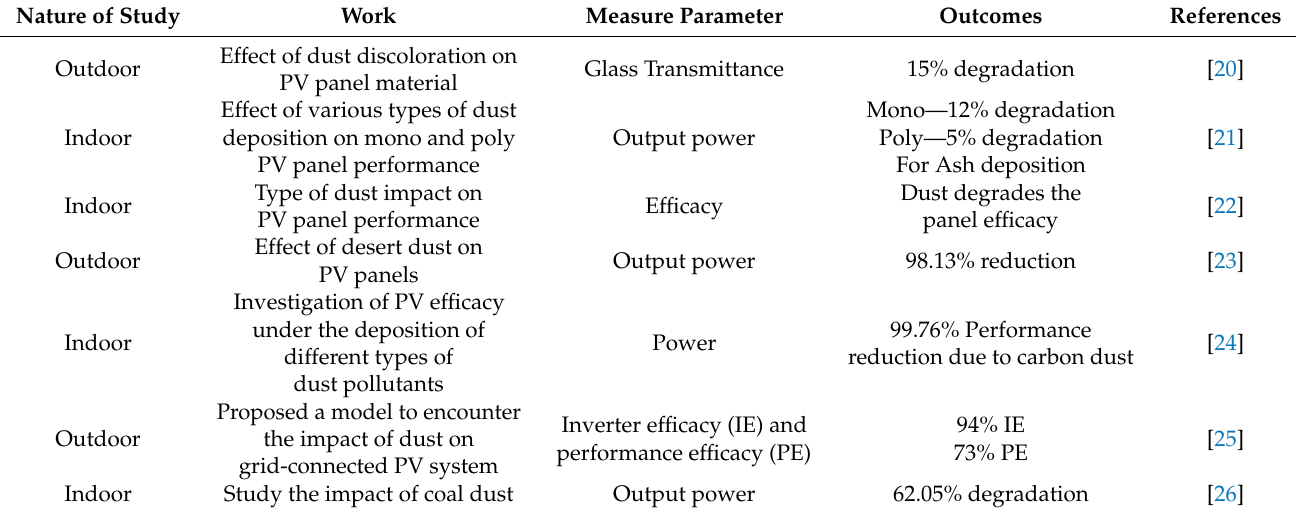
Table 1. Study and outcomes of dust effect on PV panel